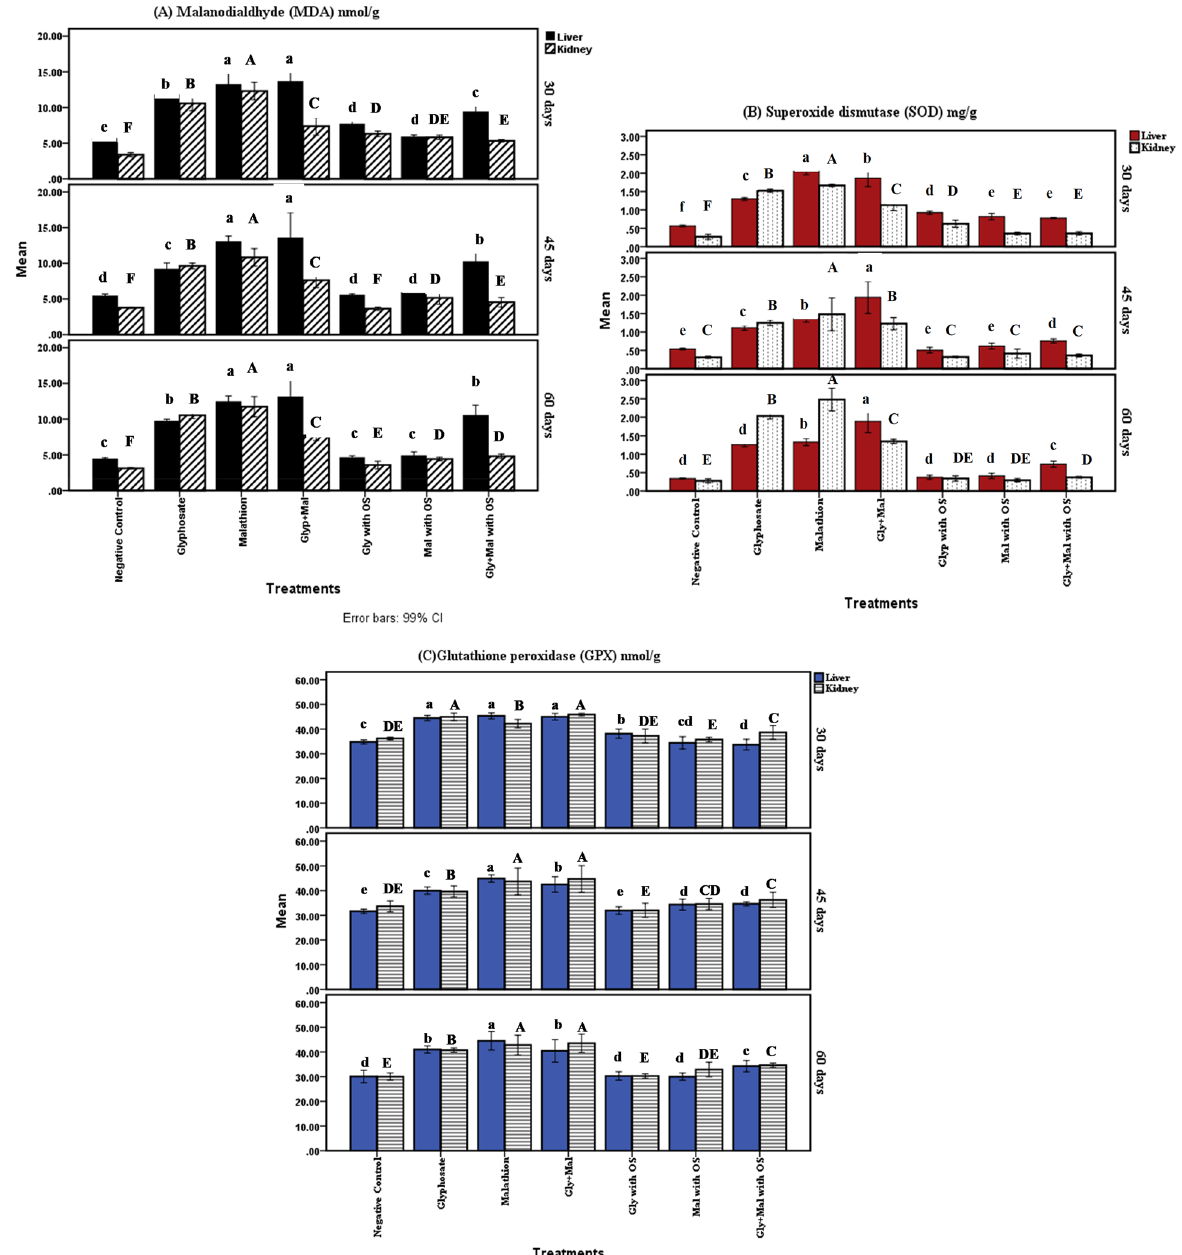
Figure 5. Glyphosate and /or malathion intoxication on oxidative stress biomarkers in Oreochromis niloticus with organic selenium supplementation. Means with different superscripts are statistically different (P <